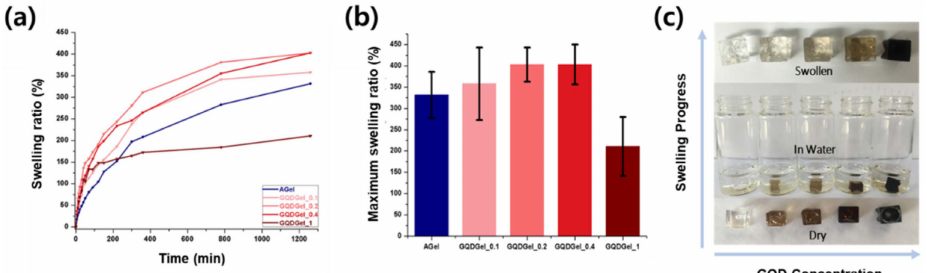
Figure 6. Swelling properties of hydrogel samples. ( a ) Calculated swelling ratio of each sample. ( b ) Average of maximum swelling ratio. The experiments were performed in triplicate. ( c ) Photograph of hydrogel swelling process from dry to swollen in DI water of AGel, GQDGel_0.1, GQDGel_0.2, GQDGel_0.4, and GQDGel_1, from left to right,